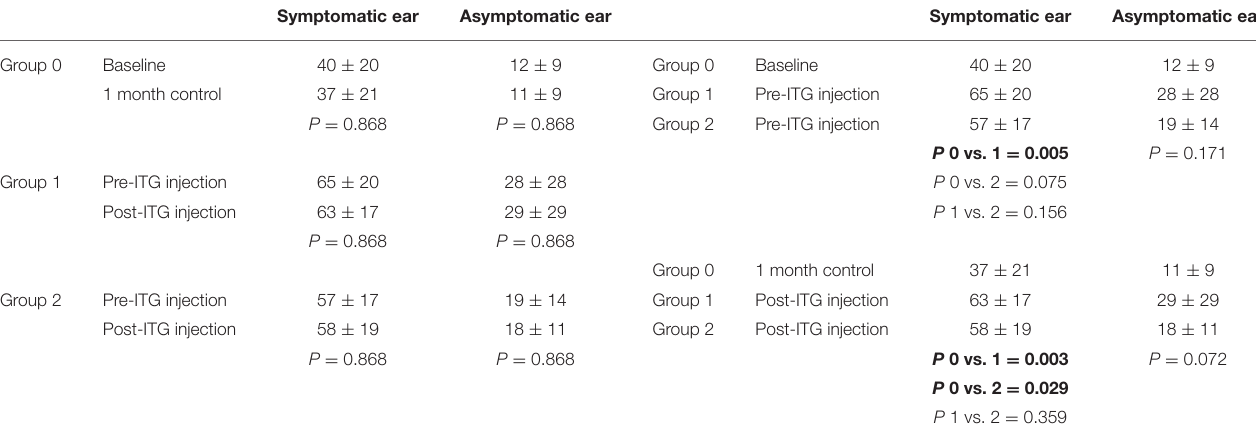
TABLE 4 | Pure tone average before and after treatment and comparison of pure tone average between groups before and after treatment. Symptomatic ear Asymptomatic ear Symptomatic ear Asymptomatic